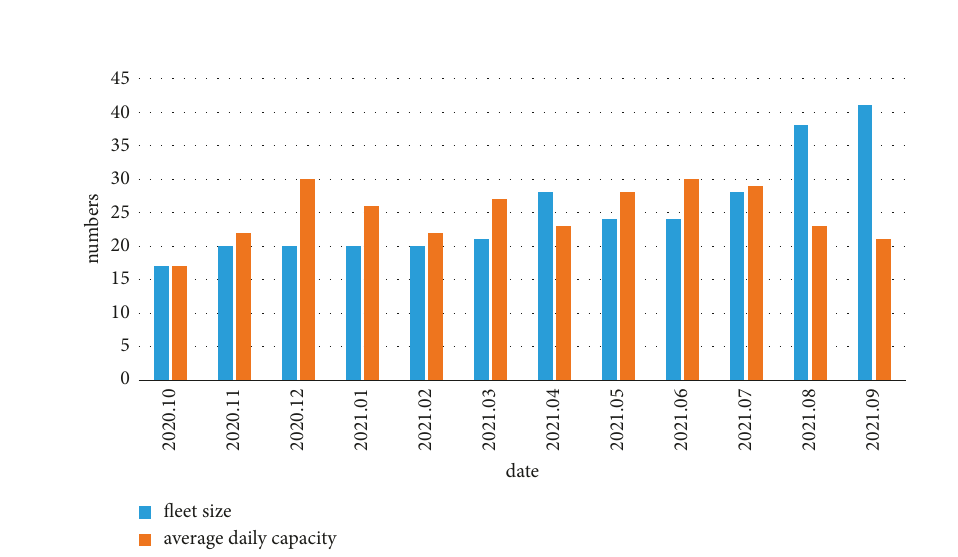
Figure 7: Operation situation of Xiong’an bus sharing.